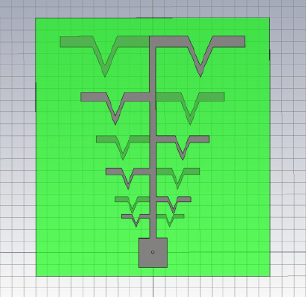
Figure 2. LPKFA with flare angle 0°.